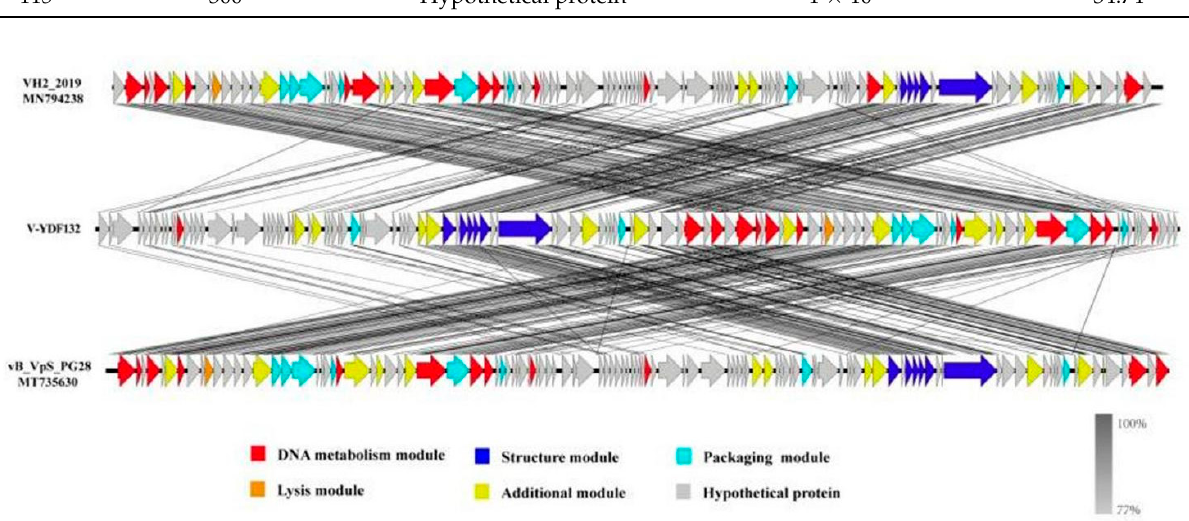
Figure 4. Multiple sequence alignment of phage genomes. The whole genomes of the Vibrio phage vB_VpS_PG28 (MT735630.2) and VH2_2019 (MN794238.1) and V-YDF132 were compared at the DNA level by using Easyfig. The black shading indicates sequence similarities between the genomes. The predicted functions of the proteins are indicated by different colors.